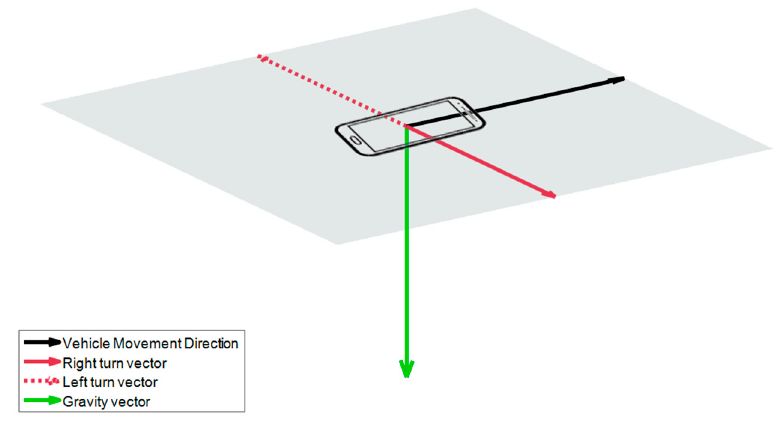
Figure 4. Distribution vectors related to the mobile.